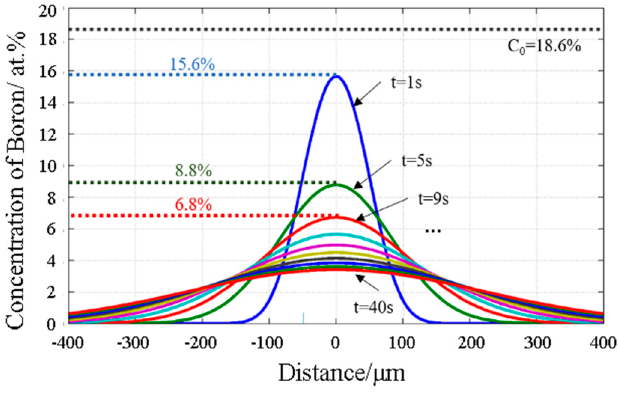
Figure 11. Effect of time on the concentration of Boron at 1160 °C.